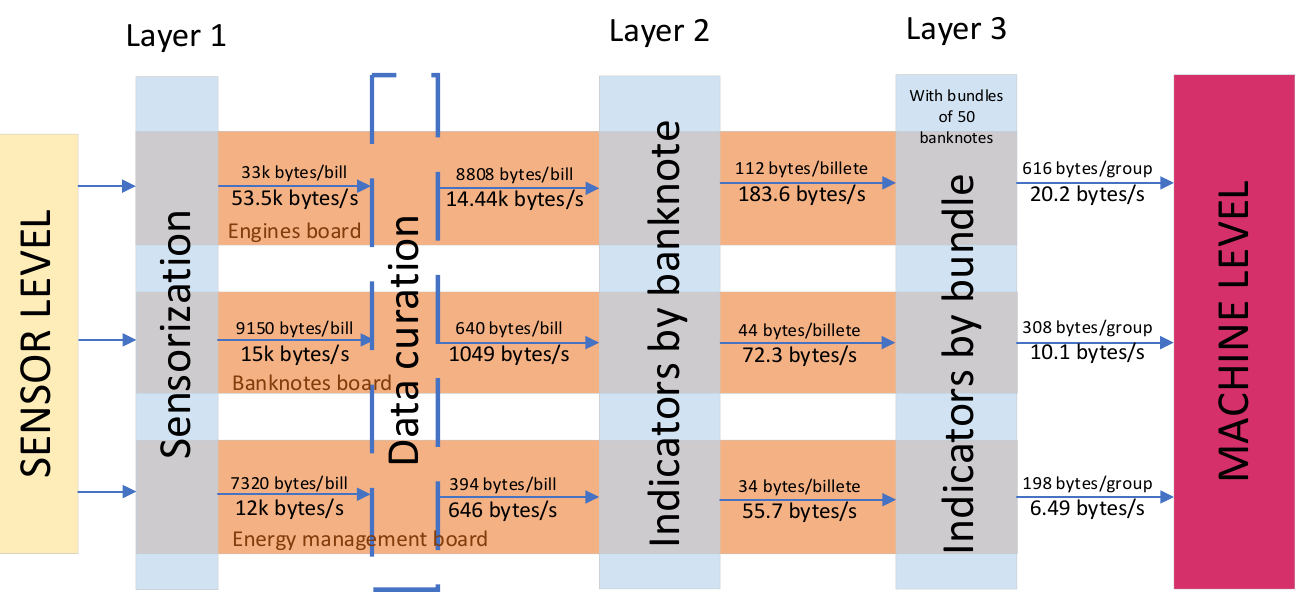
Figure 16. Diagram of the designed monitoring infrastructure.